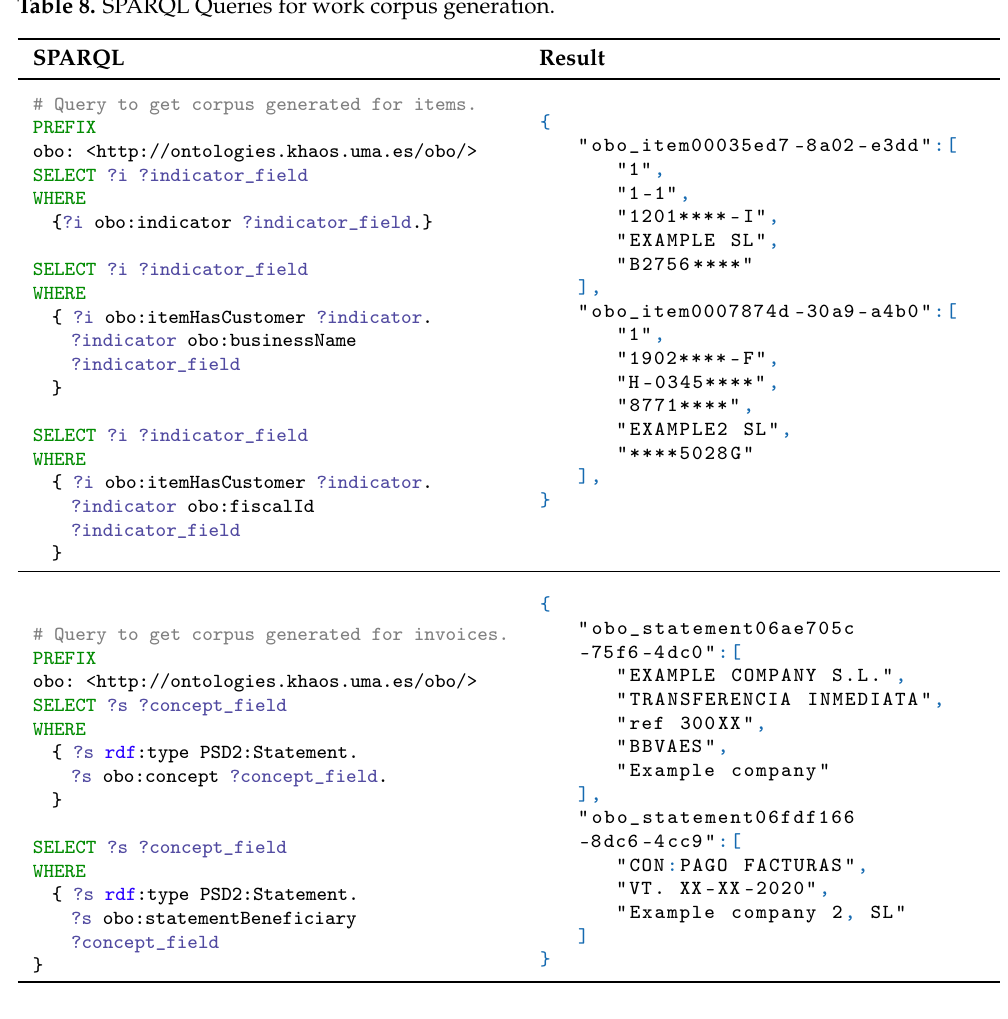
Table 8. SPARQL Queries for work corpus